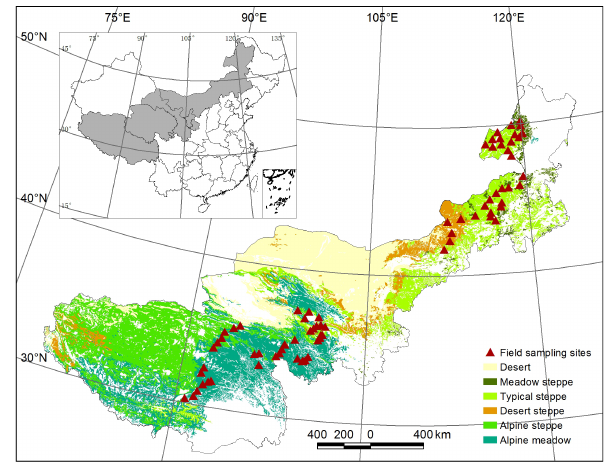
Fig. 1. Vegetation map of Chinese grasslands and location of sam- pling sites (1:1000000) (Chinese Academy of Sciences,